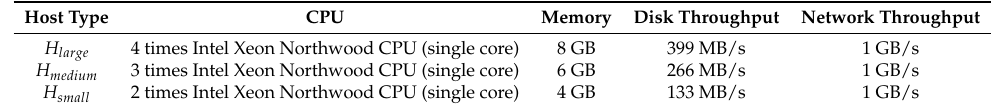
Table 1. Resource parameters of the hosts.